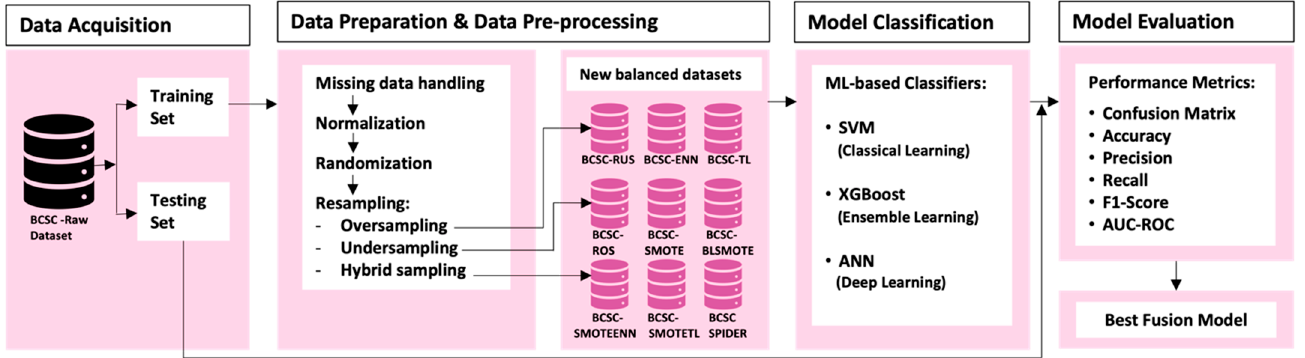
Figure 3. Proposed research method.